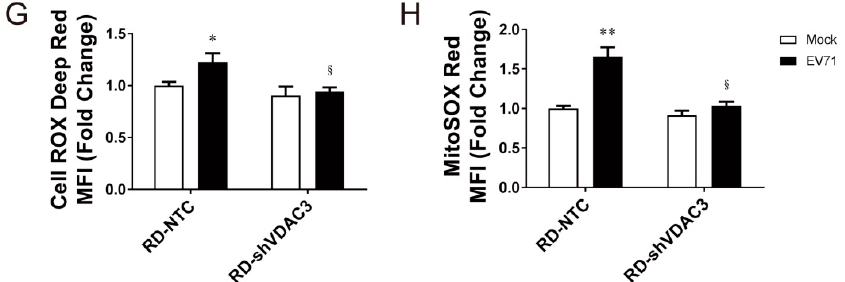
Figure 6. VDAC3 is essential to mitochondrial ROS generation. ( A – D ) Vero-shVDAC3 and Vero-NTC cells ( A , B ) were mock infected or infected with EV71 virus at an MOI of 1.25. RD-shVDAC3, and RD-NTC cells ( C , D ) were mock infected or infected with EV71 virus at an MOI of 0.01. Twenty-four hours later, the cells were stained with CellROX Deep Red ( A , C ) for quantification of total cellular ROS, or with MitoSOX Red ( B , D ) for quantification of mitochondrial ROS. ( E – H ) Vero-shVDAC3 and Vero-NTC cells ( E , F ), or RD-shVDAC3 and RD-NTC cells ( G , H ) were mock infected or infected with EV71 virus at an MOI of 10. Six hours later, the cells were stained with CellROX Deep Red ( E , G ) for quantification of total cellular ROS or with MitoSOX Red ( F , H ) for quantification of mitochondrial ROS. The MFI is expressed as fold change relative to that of mock-infected NTC cells. The results are mean ± SD, n = 6. * p < 0.05, ** p < 0.01 vs. mock-infected NTC cells; § p < 0.05 vs. infected NTC cells. To examine if interaction between 2B and VDAC3 enhances mitochondrial ROS pro- duction, we transfected Vero cells with the expression vector encoding the Myc-tagged fusion protein between non-fluorescent GPF (GFPi) and 2B (GFPi-2B-Myc) or the control protein GFPi-Myc, and determined the level of mitochondrial ROS in the transfected cells. As shown in Figure 7A, expression of 2B increased the MitoSOX Red fluorescence in- creased by nearly twofold. However, the fluorescence intensity diminished upon treatment with Mito-TEMPO (Figure 7B). We further studied if VDAC3 is essential to mitochondrial ROS generation. We transfected Vero-shVDAC3 and Vero-NTC cells with the expression vector encoding GFPi-2B-Myc or GFPi-Myc, and quantified mitochondrial ROS. Expres- sion of 2B significantly increased MitoSOX Red fluorescence in Vero-NTC cells but not in Vero-shVDAC3 cells (Figure 7C), suggestive of an essential role of VDAC3 in 2B-induced mitochondrial ROS formation. These findings suggest that 2B interacts with VDAC3 to regulate mitochondrial ROS generation.